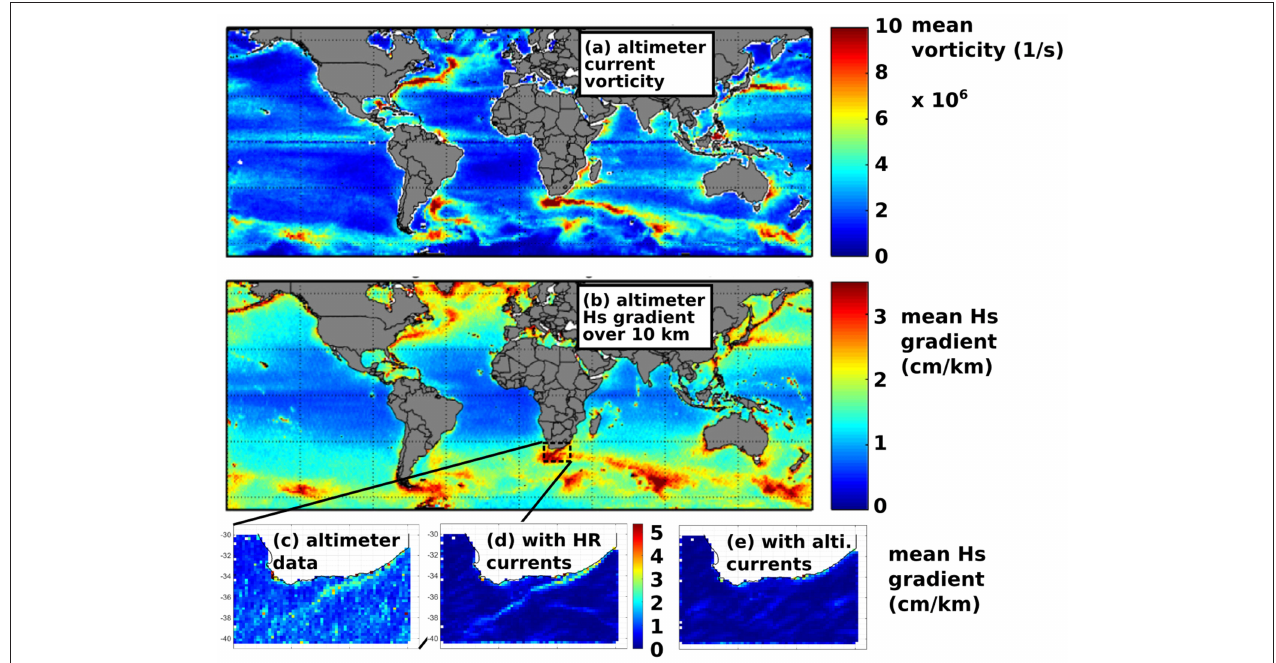
FIGURE 2 | (a,b) show 4-year mean (2013-2016) computed using the constellation of 4 satellite altimeters, of current vorticity estimated from gridded altimeter data, and along-track gradient of significant wave height. (c) is a higher resolution grid over the Agulhas current for August 2015, compared to (d) a WAVEWATCH III model run forced by 1-km resolution modeled currents, and (e) forced by altimeter-derived gridded currents (Adapted from Quilfen et al., 2018 as authorized by Elsevier).